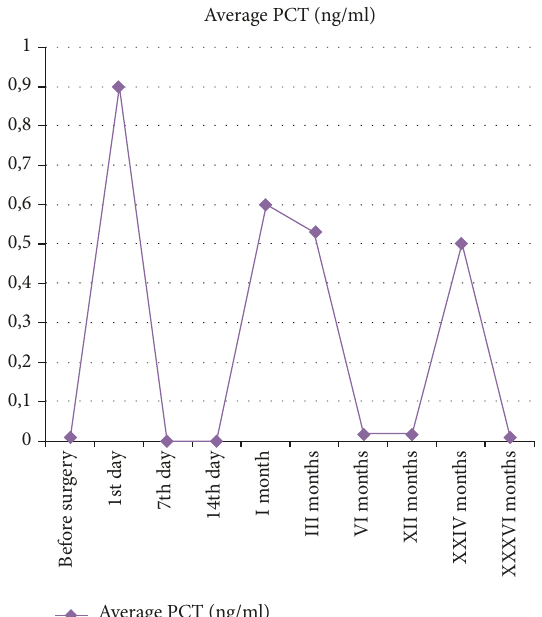
Figure 3: Trend of PCT during 36 months of follow-up.